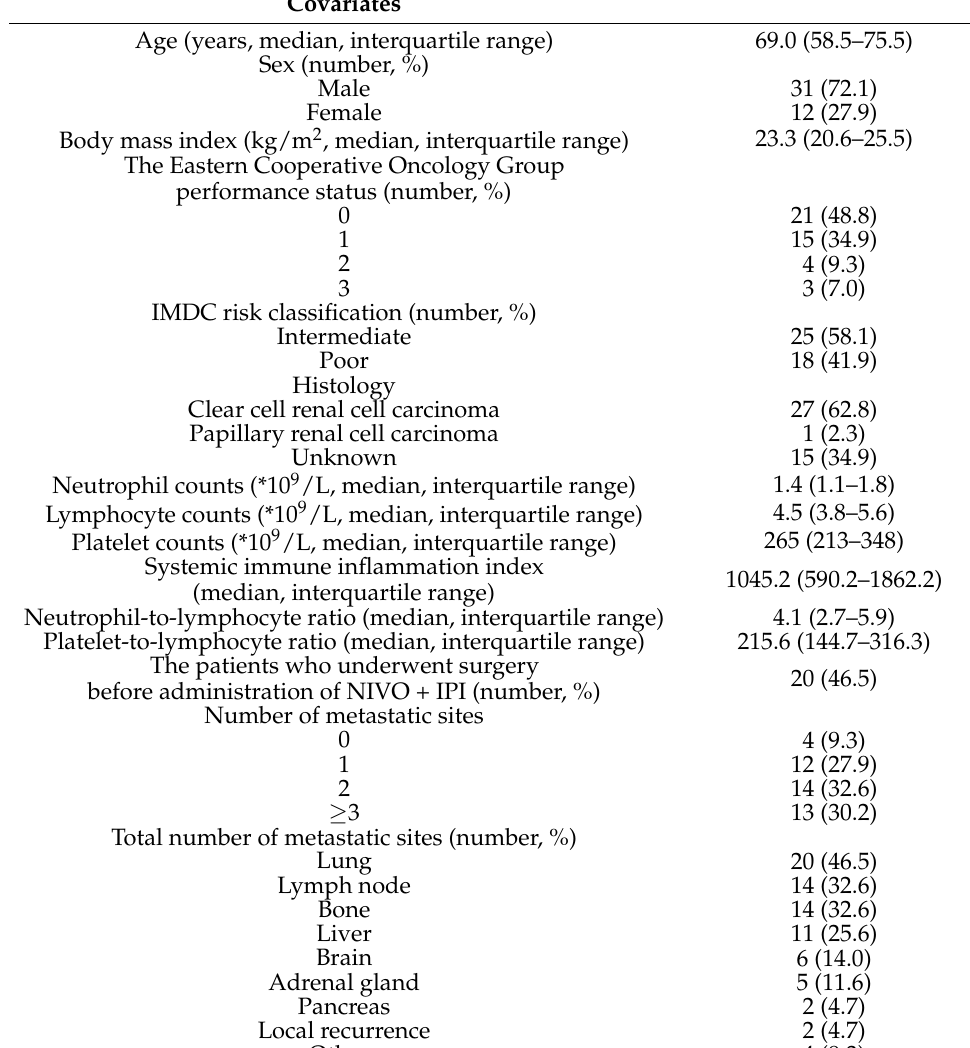
Table 1. Demographic data for the enrolled